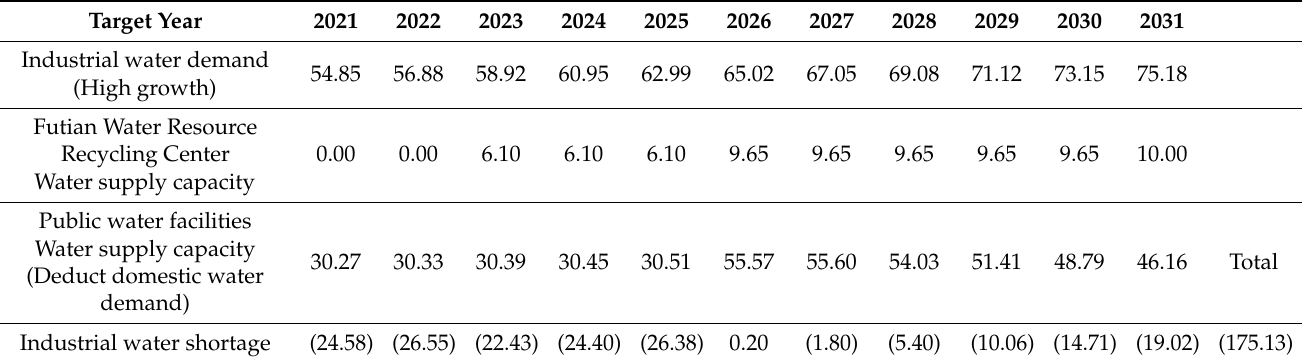
Table 9. Estimate of Shortage in Industrial Water in Taichung under Climate